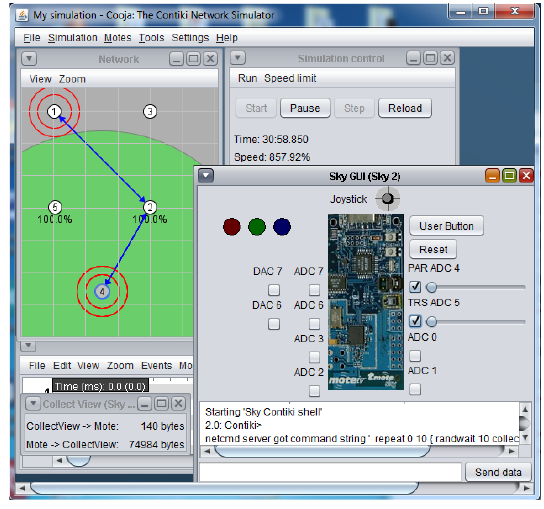
Figure 8. Advanced Sky GUI.